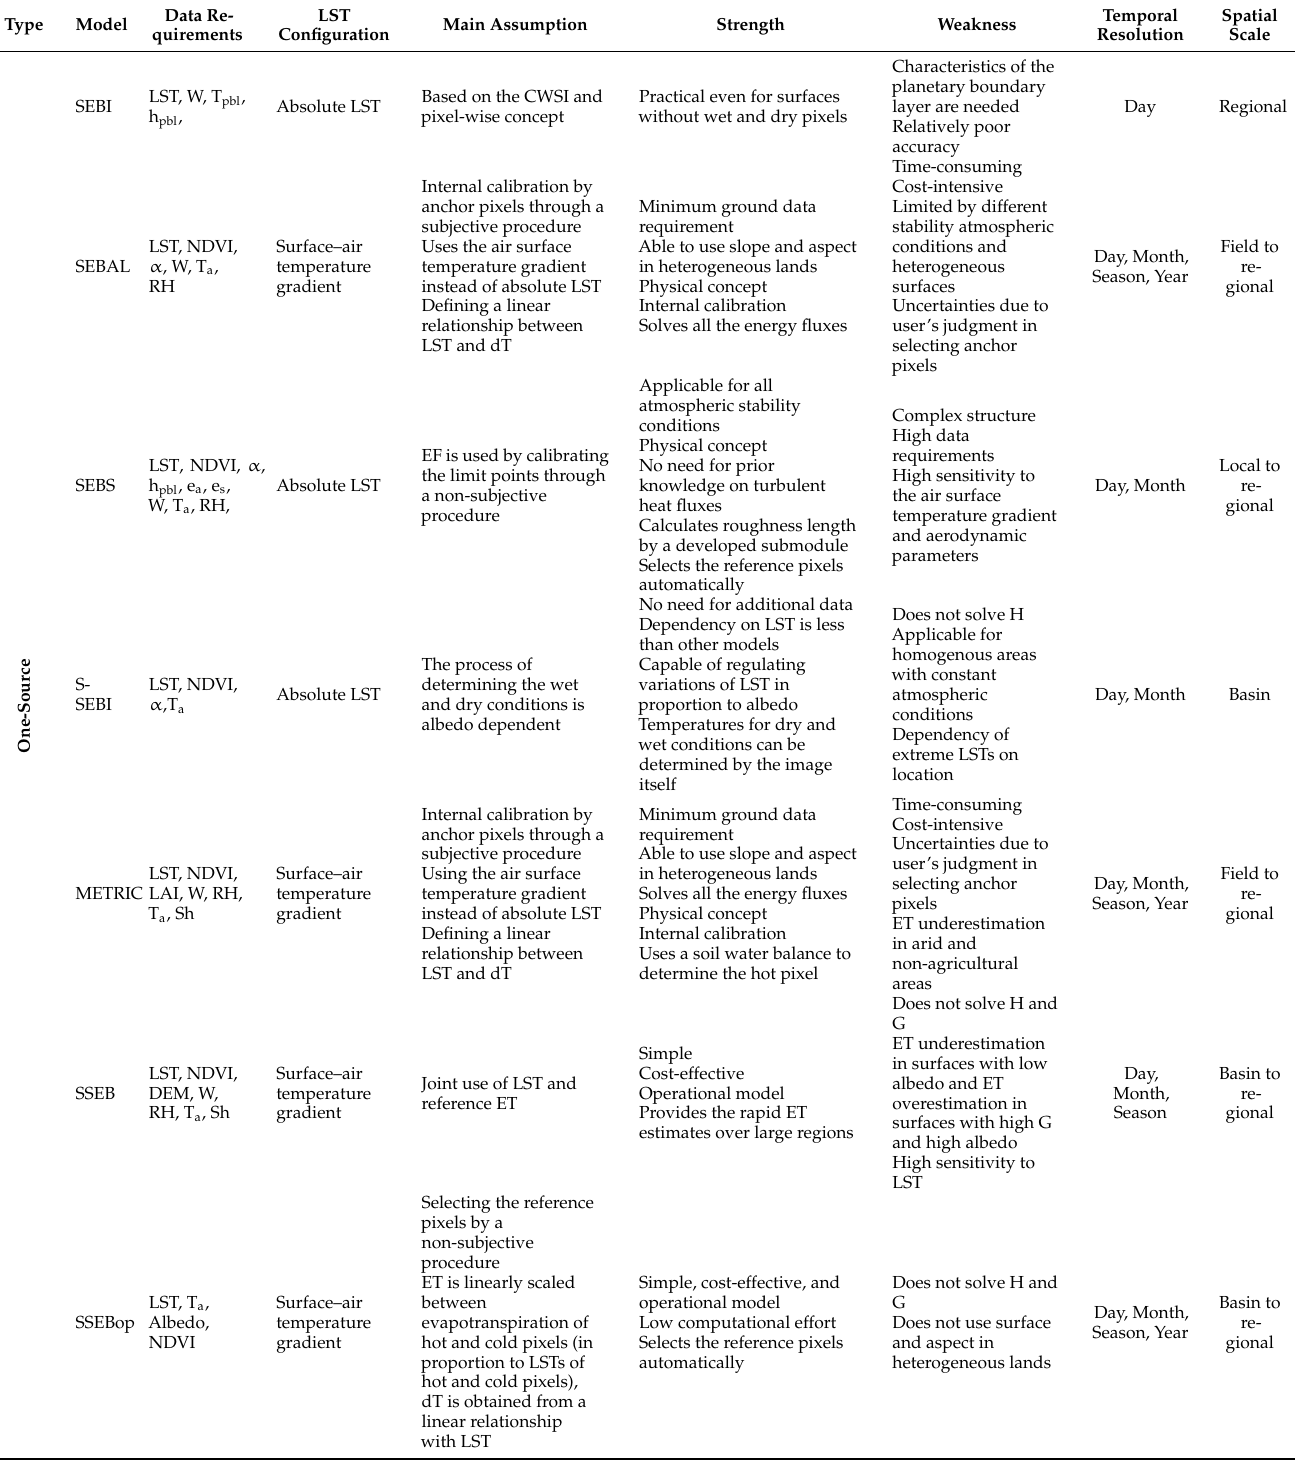
Table 2. A summary of the remote sensing ET models that follow approach